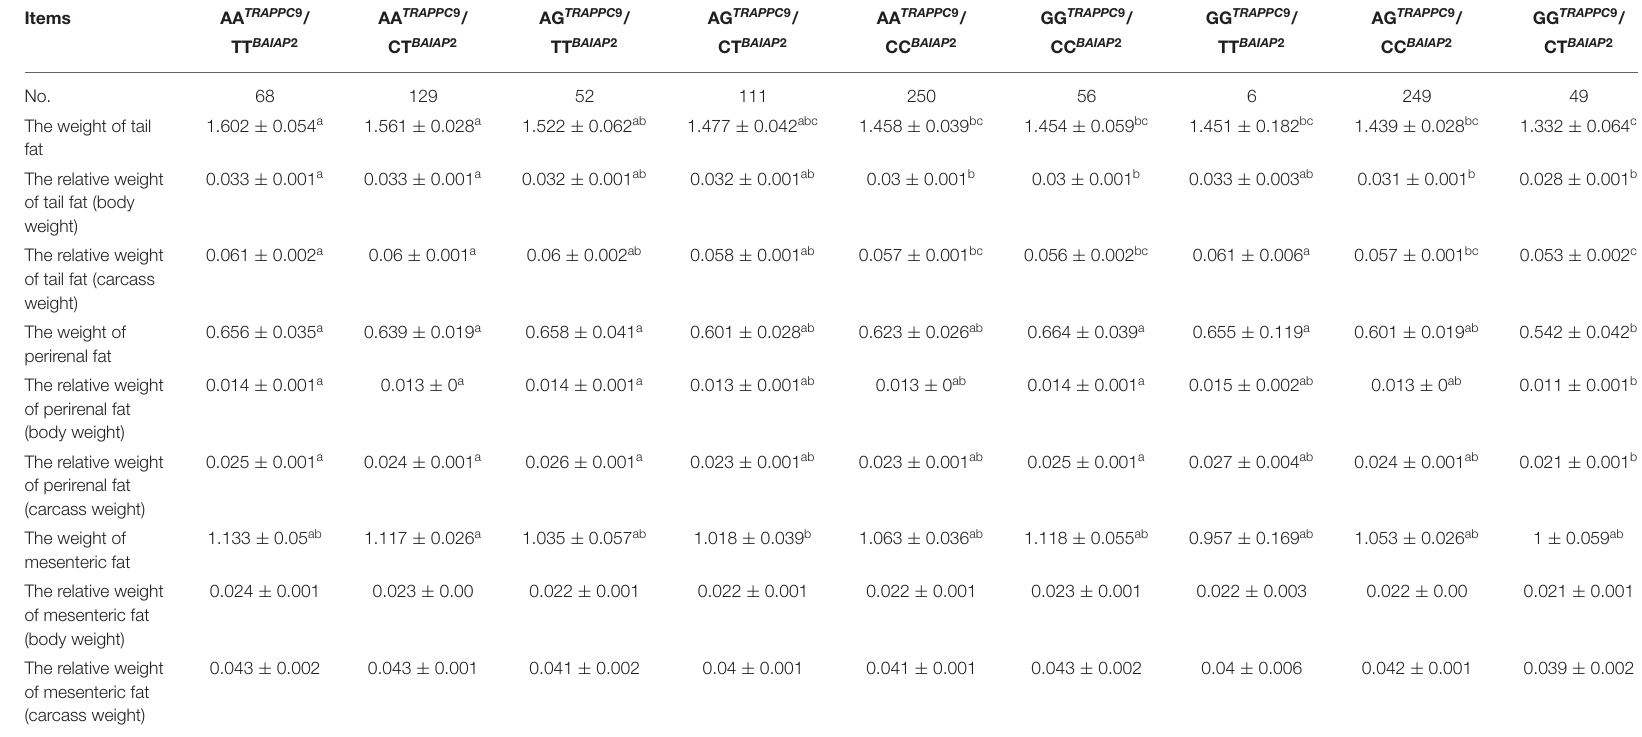
TABLE 7 | Analysis of the associations of combined genotypes at the TRAPPC9 and BAIAP2 loci and sheep tail fat deposition